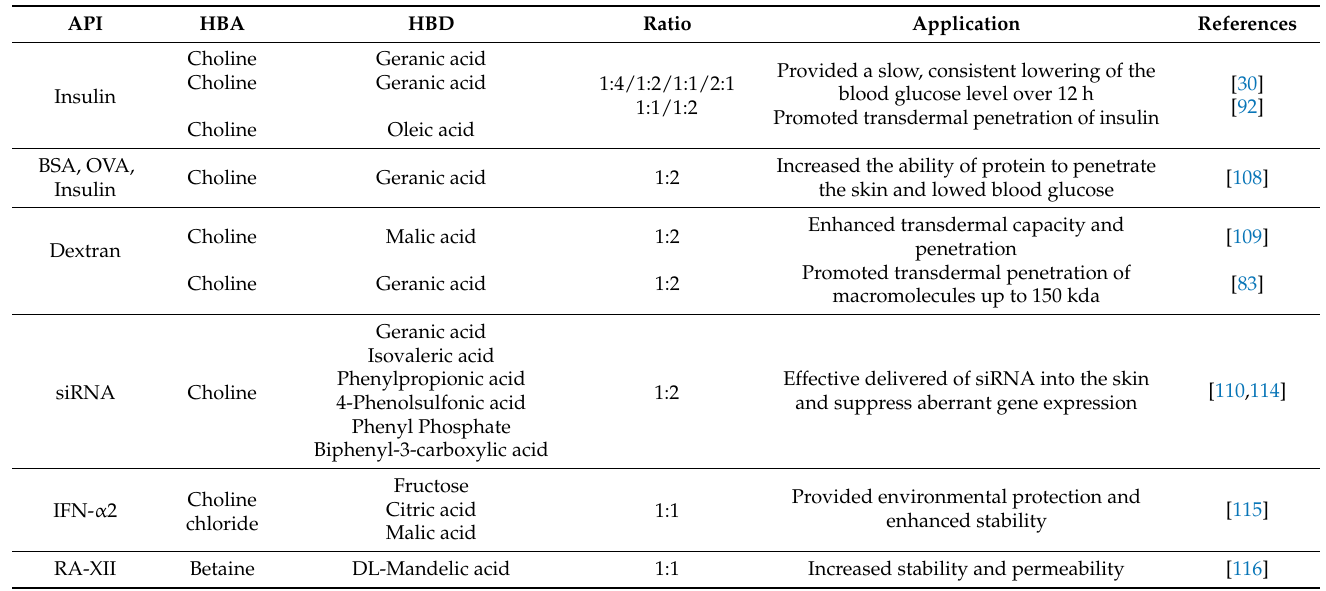
Table 3. The applications of some DESs for transdermal delivery of